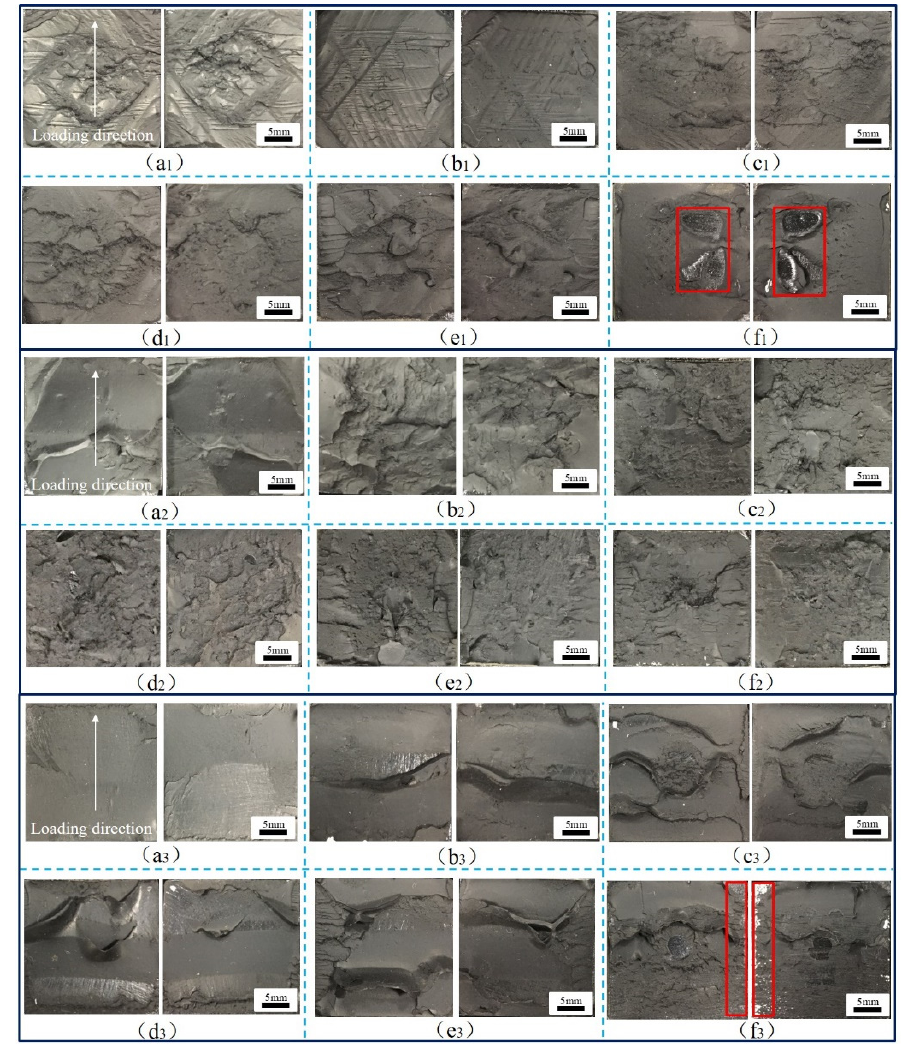
Figure 14. TASJs, high temperature: ( a 1 ) 0, ( b 1 ) 6, ( c 1 ) 12, ( d 1 ) 18, ( e 1 ) 24, ( f 1 ) 30 days; room temperature: ( a 2 ) 0, ( b 2 ) 6, ( c 2 ) 12, ( d 2 ) 18, ( e 2 ) 24, ( f 2 ) 30 days; low temperature: ( a 3 ) 0, ( b 3 ) 6, ( c 3 ) 12, ( d 3 ) 18, ( e 3 ) 24, ( f 3 ) 30 days.